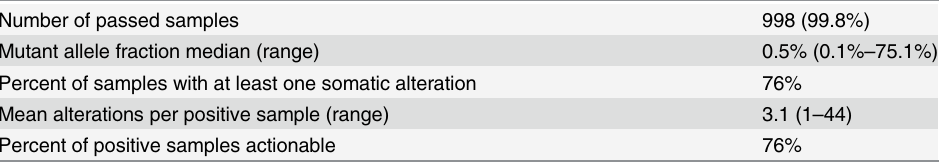
Table 5. Initial 1,000 consecutive samples from clinical practice (pan-cancer stages